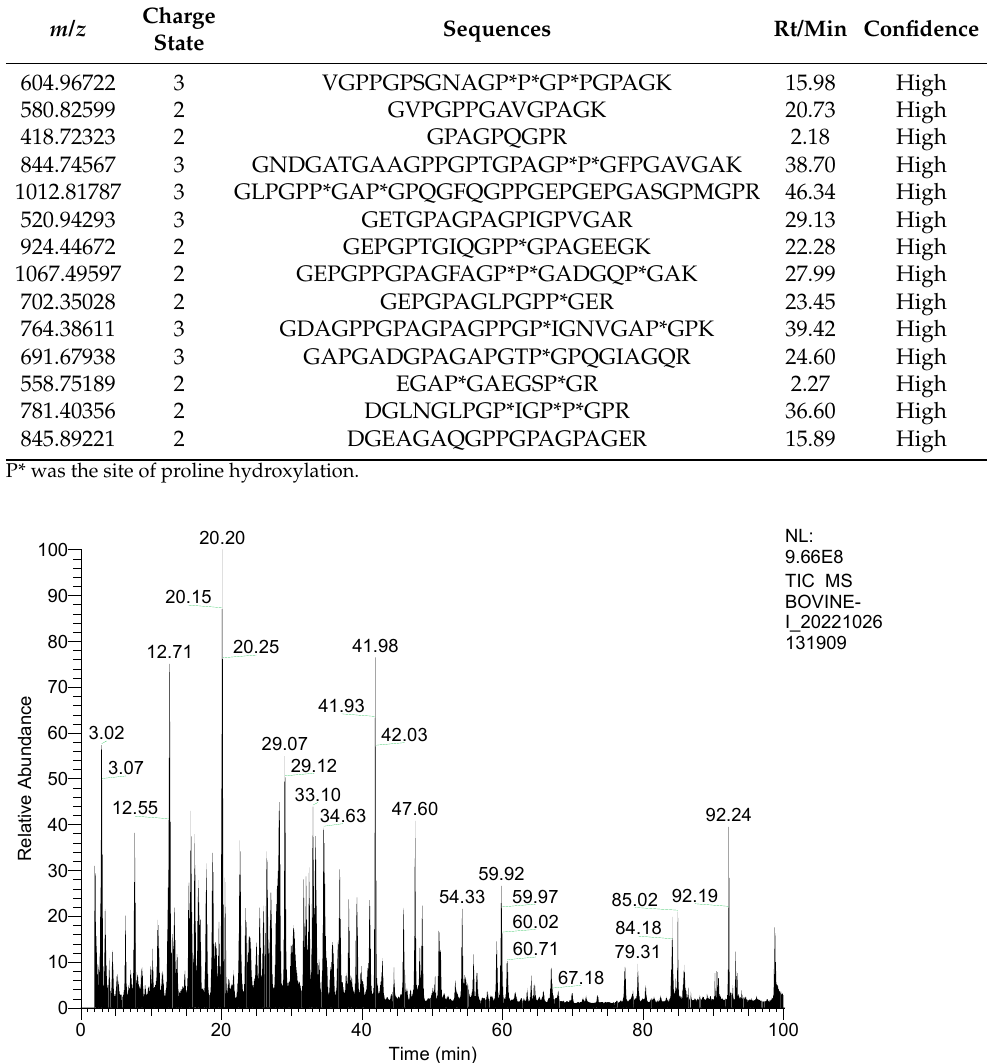
Figure 4. The extracted ion chromatogram ( A ) and MS spectrum ( B ) of m/z 418.723 detected in the digested bovine type I collagen reference material. Figure 5. MS/MS spectrum of m/z 418.721 detected in digested bovine type I collagen reference ma- terial.